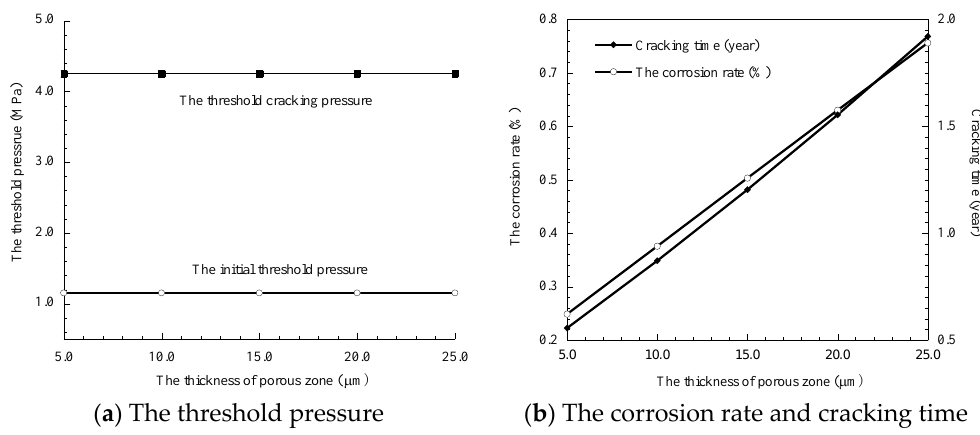
Figure 5. Influence of the thickness of the porous zone.